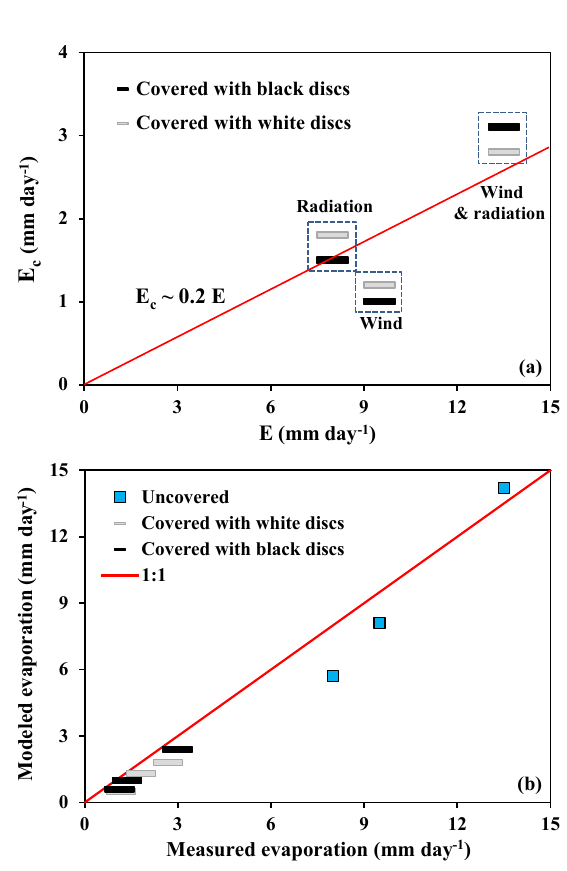
Figure 6. (a) Laboratory results of evaporative loss from a small water basin covered with floating discs of 0.2m diameter (see Fig. 4); the ratio between evaporation from covered and uncovered reservoirs is about 0.2, corresponding to suppression efficiency of about 80%; (b) modeled vs. measured mean evaporation rate from uncovered and covered basin for different forcing marked in (a)